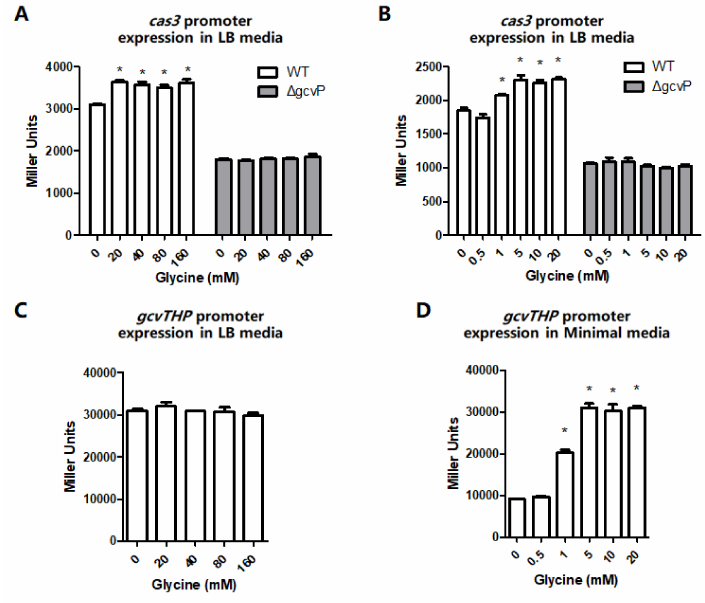
Figure 3. cas3 and gcvTHP promoter expression are activated by glycine. ( A ) The β -gal activity of the cas3 promoter was measured by reporter plasmids in WT or ∆ gcvP cultured in Luria-Bertani (LB) media supplemented with 0, 20, 40, 80, or 160 mM glycine. The cas3 promoter was activated by glycine in WT. ( B ) The β -gal activity of the cas3 promoter was measured by reporter plasmids in WT or ∆ gcvP cultured in minimal media supplemented with 0, 0.5, 1, 5, 10, or 20 mM glycine. The cas3 promoter was activated by the minimal of 1 mM glycine in WT. ( C ) The β -gal activity of the gcvTHP promoter was measured by reporter plasmids in WT (EC12) cultured in LB media supplemented with 0, 20, 40, 80, or 160 mM glycine. The supplemented glycine in LB media had no e ff ect on the expression of the gcvTHP promoter. ( D ) The β -gal activity of the gcvTHP promoter was measured by reporter plasmids in WT cultured in minimal media supplemented with 0, 0.5, 1, 5, 10, or 20 mM glycine. The gcvTHP promoter activity started to increase with 1 mM glycine. All the data were mean ± SEM of at least three replicates, and the p value (* p < 0.05) was analyzed by the t -test.